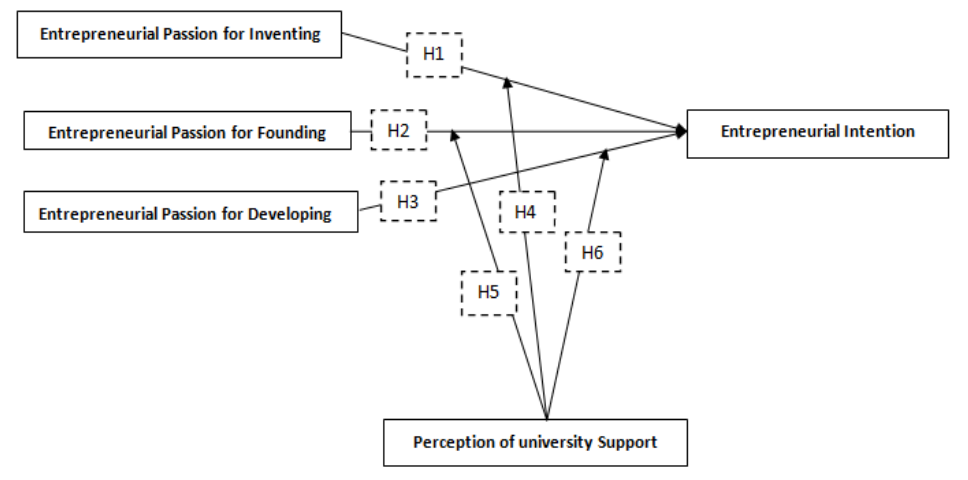
Figure 1. Conceptual Framework.